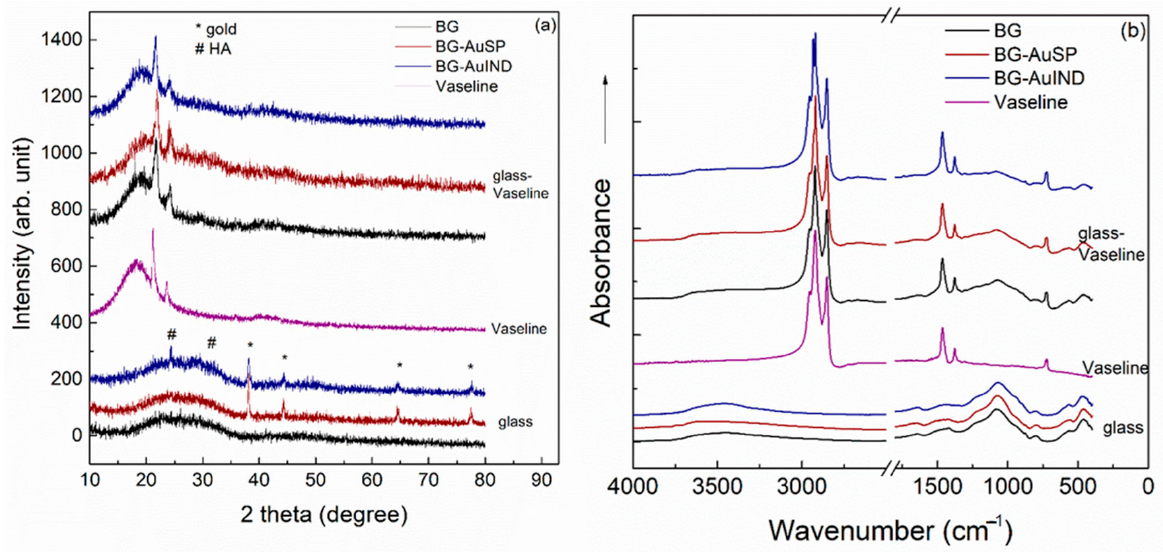
Figure 4. X-Ray Diffraction (XRD) patterns ( a ) and Fourier transform infrared (FTIR) spectra ( b ) of the BG and BG-AuSP, BG-AuIND, Vaseline, BG-Vaseline, BG-AuSP-Vaseline and BG-AuIND-Vaseline composites.